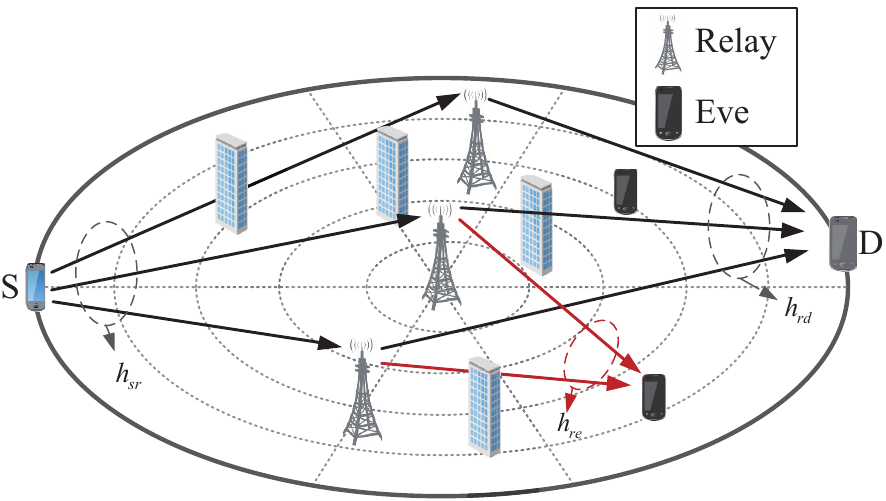
Figure 1. The SWIPT-assisted relay communication network model.